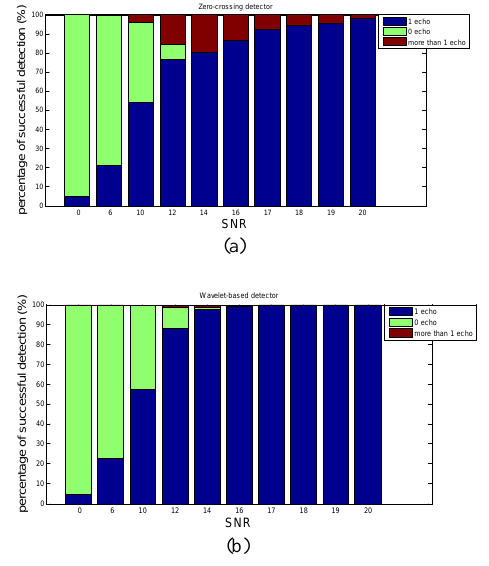
Figure 5. Results of echo detection, CR1: blue, MR1: green, RR1: red, (a) zero-crossing, (b)